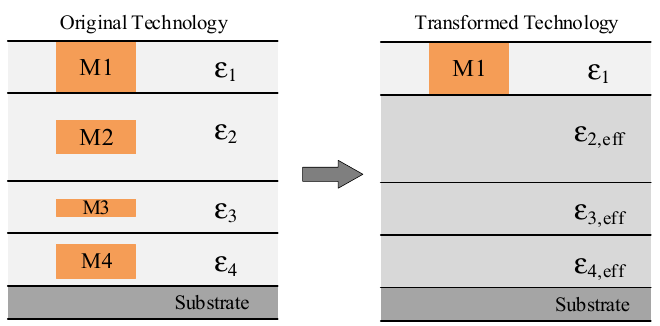
Figure 1. Conversion of metal filling into equivalent relative